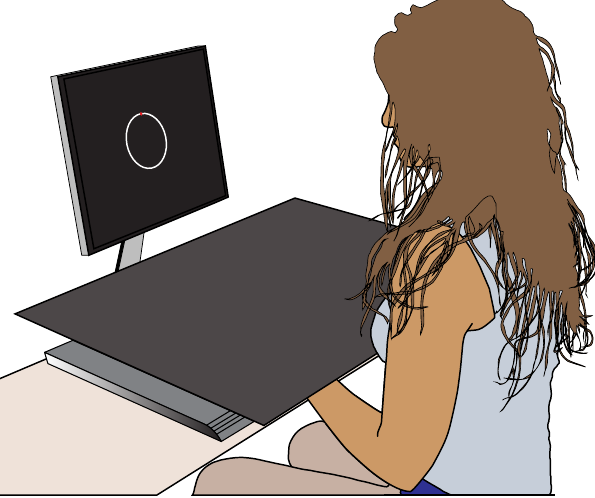
Figure 1. Setup. Diagram illustrating the experimental setup. Each subject was presented a circle template projected on a monitor in front of her/him at eye level. A black paperboard occluded vision of the hand. The subjects executed tracings of a circle, while seated without the support of either wrist, arm, or elbow, in such a way that the only contact with the tablet was made through the